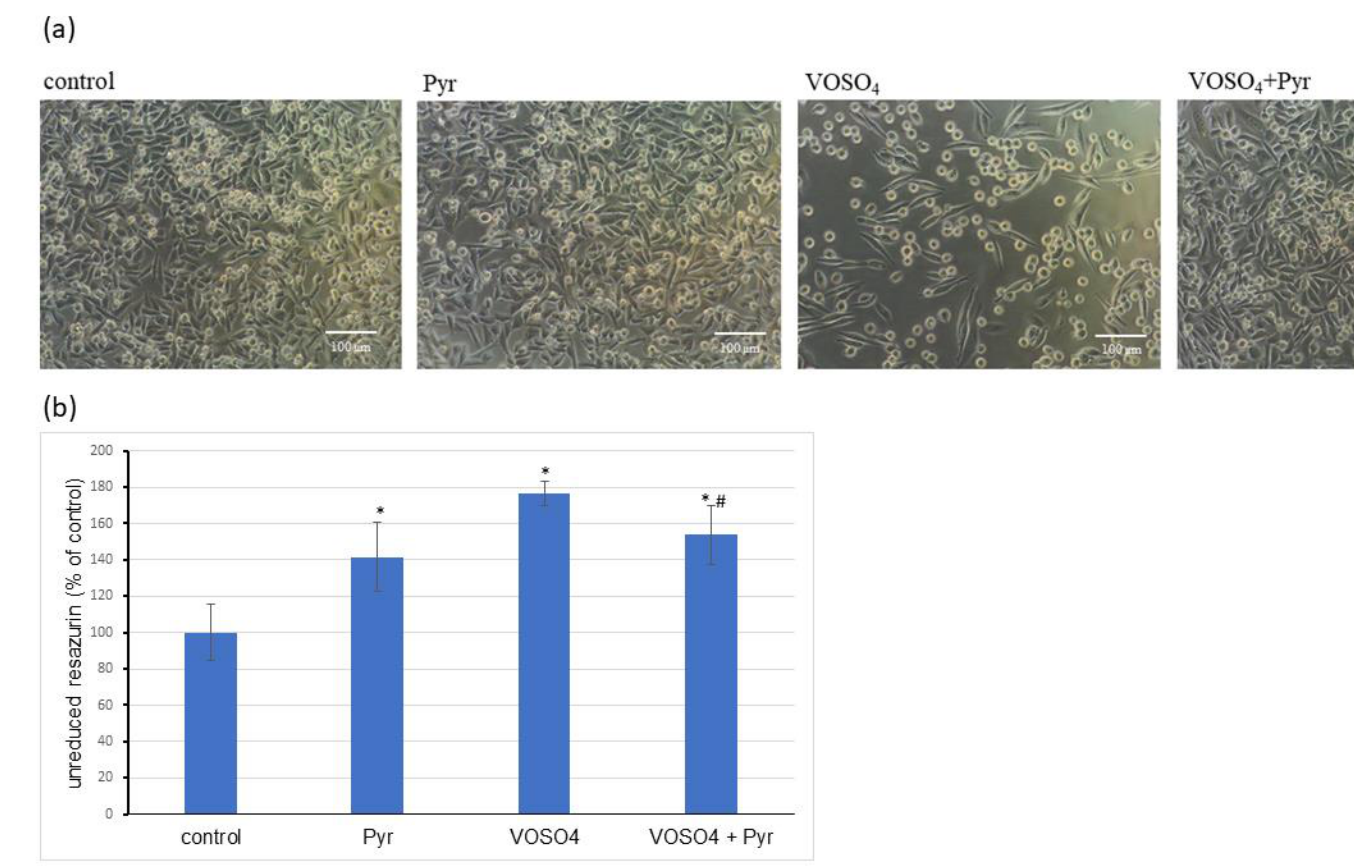
Figure 1. Effects of pyruvate on VOSO 4 -induced cytotoxicity in CHO-K1 cells. The CHO- K1 cells were treated with 100 μM VOSO 4 in the presence or absence of sodium pyruvate (Pyr) (4.5 mM) for 24 h. ( a ) Morphology of CHO-K1 cells under the phase-contrast microscope (scale bar = 1 00 μM), ( b ) resazurin-based cytotox- icity assay. Data represent the mean ± SD of two distinct experiments each performed with sixplicate determinations of each data point, * p < 0.001, versus the control group, # p < 0.05 versus the VOSO 4 -treated group. Dat a were analysed by Student’s t -test.